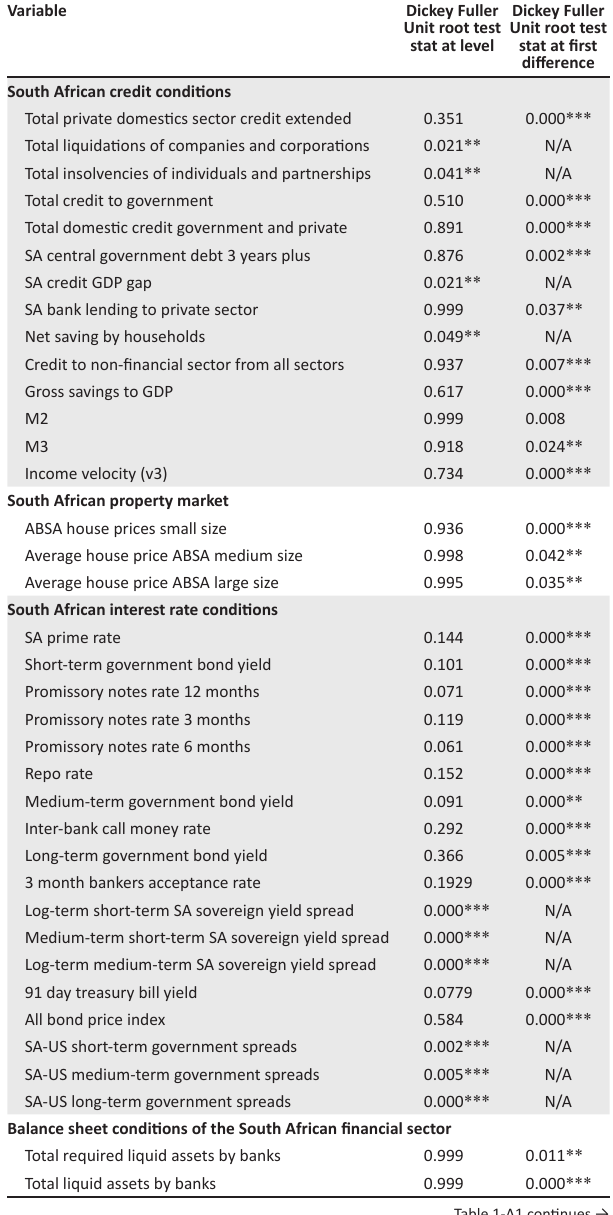
TABLE 1-A1: Unit root test results for representing variables in each South African financial sections.